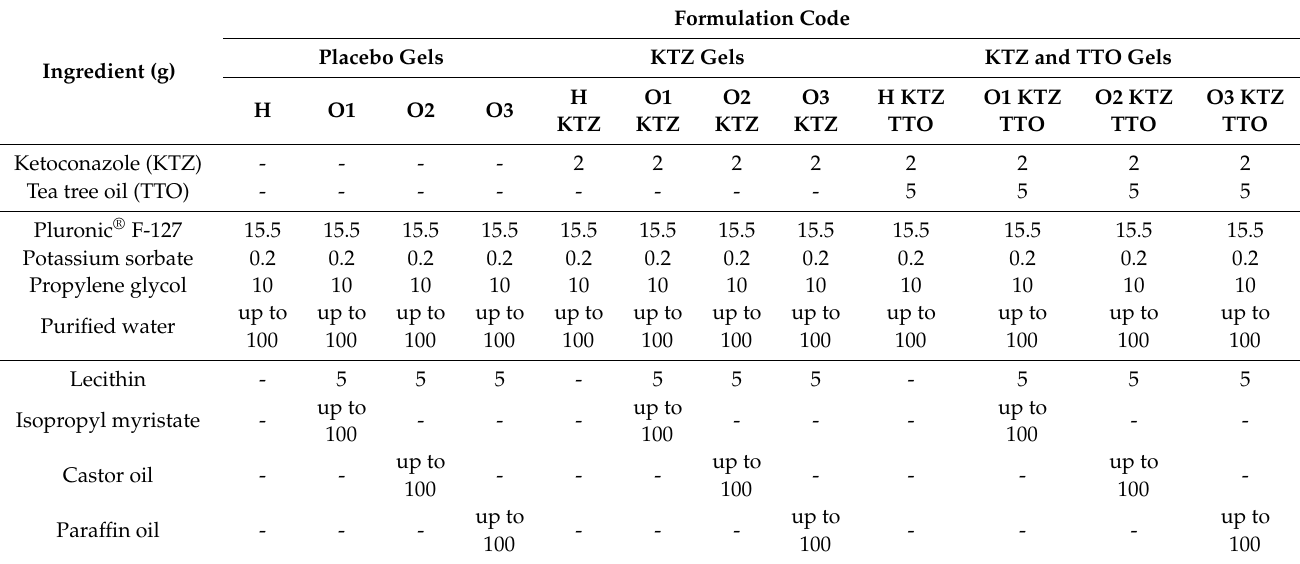
Table 2. Compositions of designed gel formulations (PLU ® F-127 hydrogels and PLO organogels).